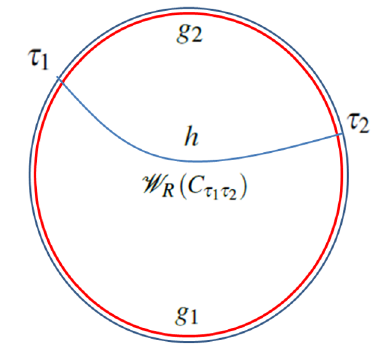
Figure 1 . The blue line crossing the disk corresponds to the boundary anchored Wilson line W λ (C τ ) , which splits the original surface into two regions that can be continuosly deformed into 1 τ 2 a